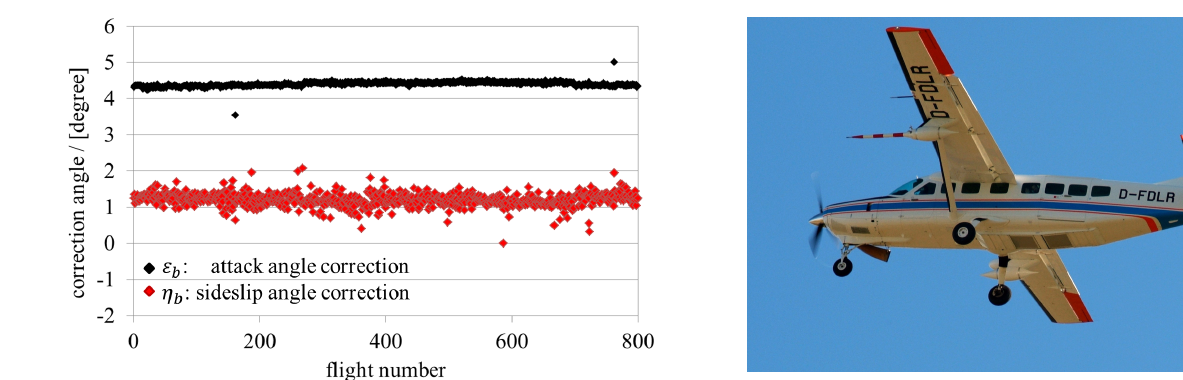
Figure 2. Results of the flow angle correction for 803 flights with the DLR Falcon20 research aircraft after 2001. The correction for the attack angle offset ( α ) shows significantly less scatter than for the sideslip angle ( β ). The offset of α ∼ 4 ◦ corresponds to a mean attack angle during normal flight conditions. The nose boom on the aircraft is tilted downward about this angle to achieve a straight flow towards the gust probe.